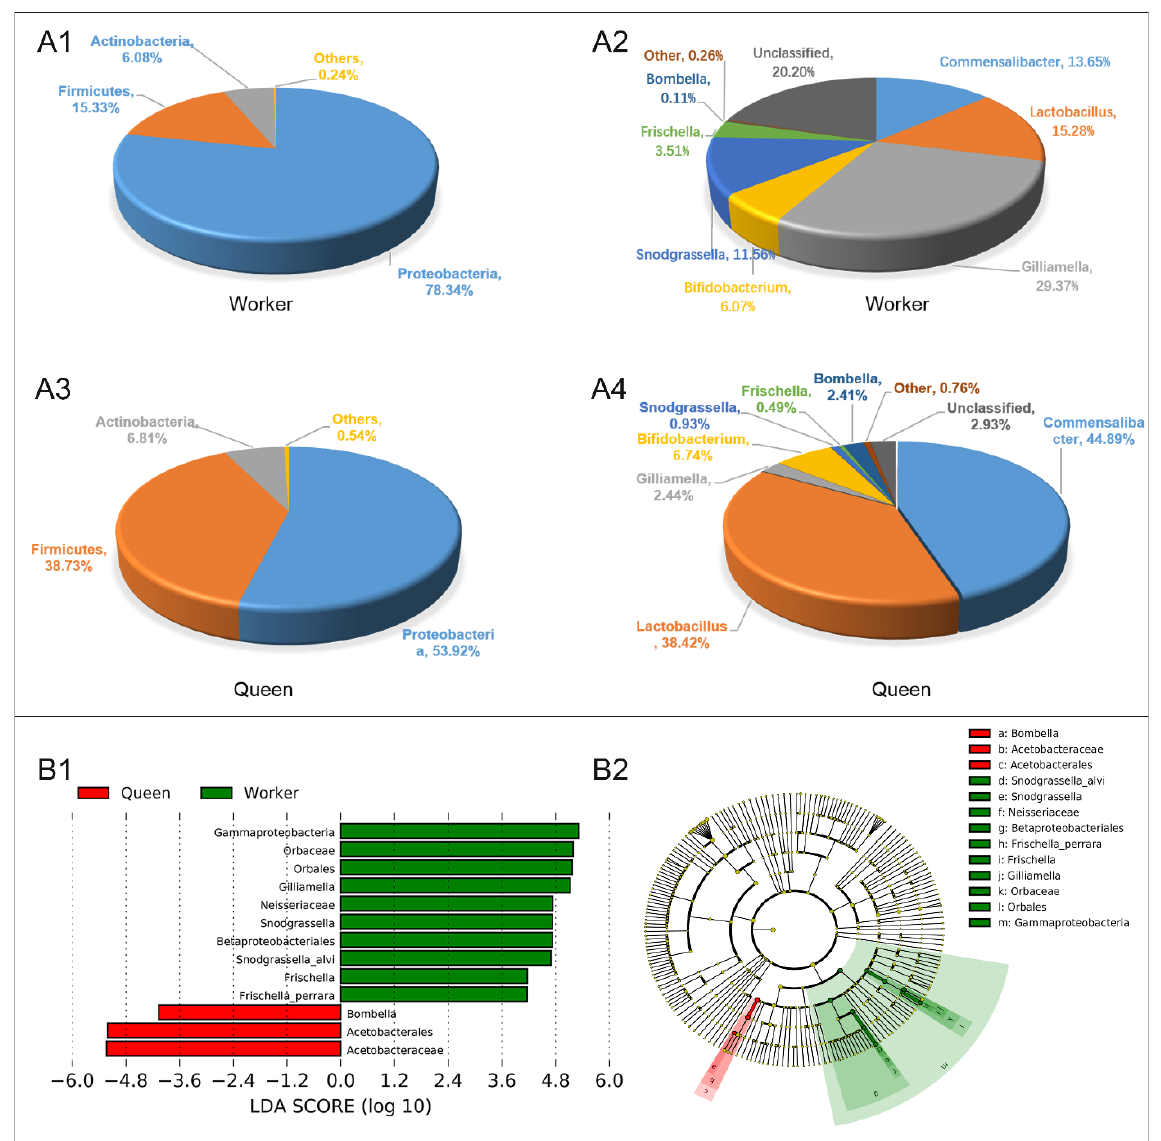
Figure 4. Gut microbial abundance and taxonomic distribution of the workers and queens. ( A1 ). Gut microbial composition and relative abundance of worker bee at phylum level; ( A2 ). Gut microbial composition and relative abundance of worker bee at genus level. ( A3 ). Gut microbial composition and relative abundance of queen bee at phylum level; ( A4 ). Gut microbial composition and relative abundance of queen bee at genus level; ( B1 ). LEfSe analysis (taxa with LDA scores > 4). ( B2 ). Cladogram of the biomarker main taxa of the microbiotas based on LEfSe analysis. Green represents significantly different taxa with the highest relative abundances in worker guts; red represents significantly different taxa, with their highest relative abundances in the queen gut.